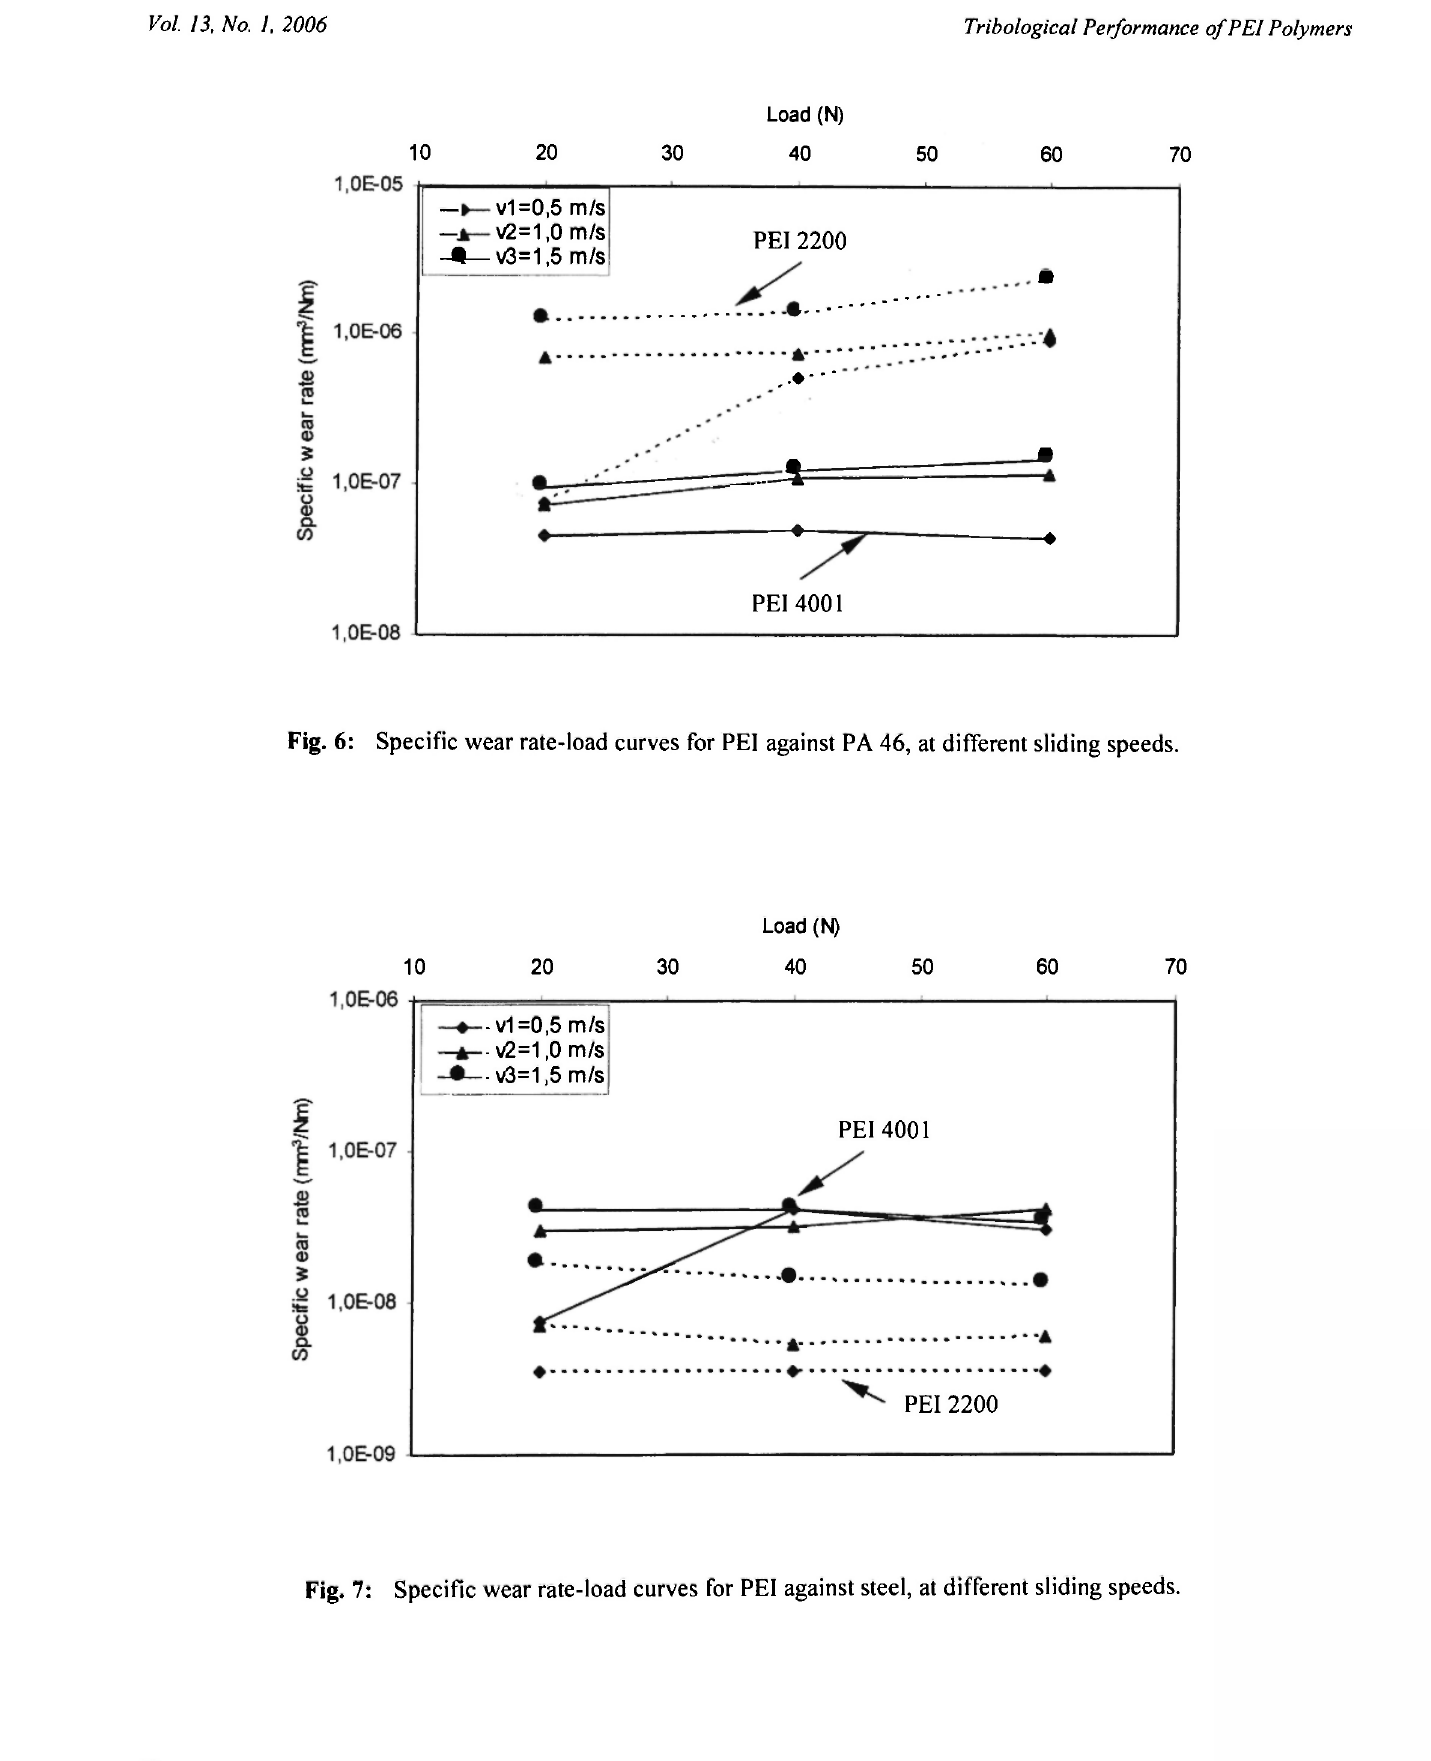
Fig. 7: Specific wear rate-load curves for PEI against steel, at different sliding